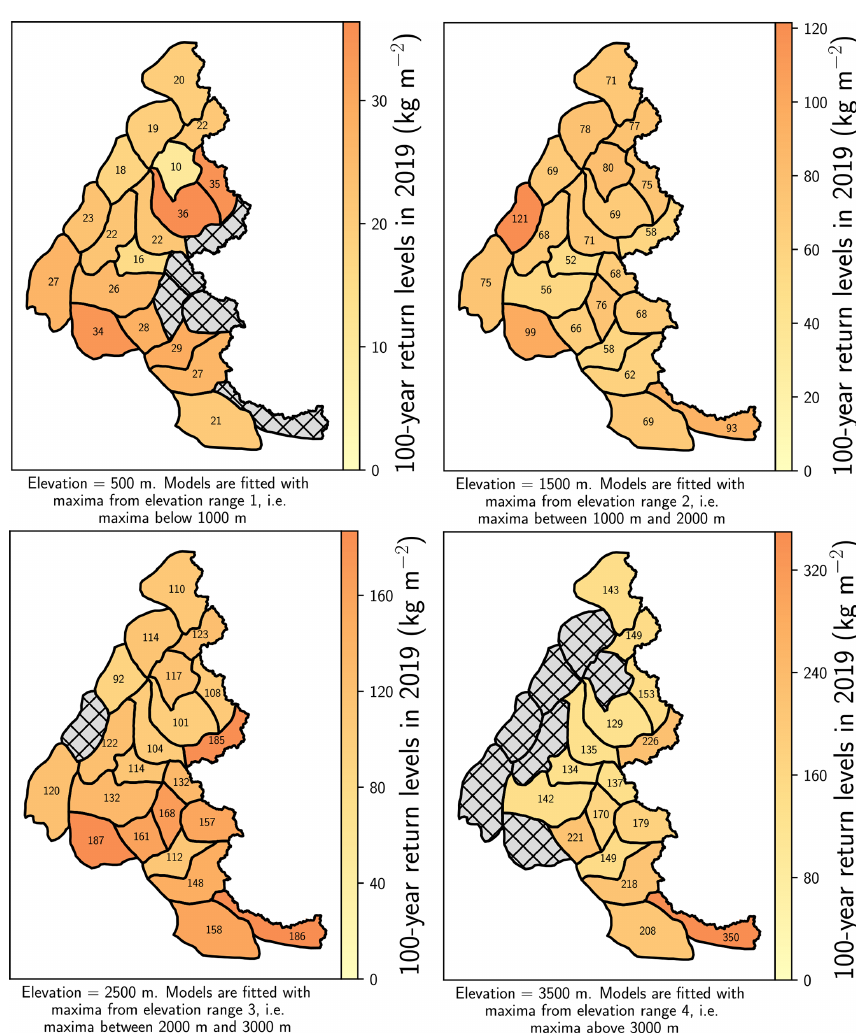
Figure 9. The 100-year return levels in 2019 of daily snowfall for each range of elevations. The 100-year return levels are both illustrated with colors (elevation-range-dependent scale) and written on the map. Hatched grey areas denote missing data, e.g., when the elevation is above the top elevation of the massif. Return levels are computed at the middle elevation for each range, e.g., at 1500m for the range